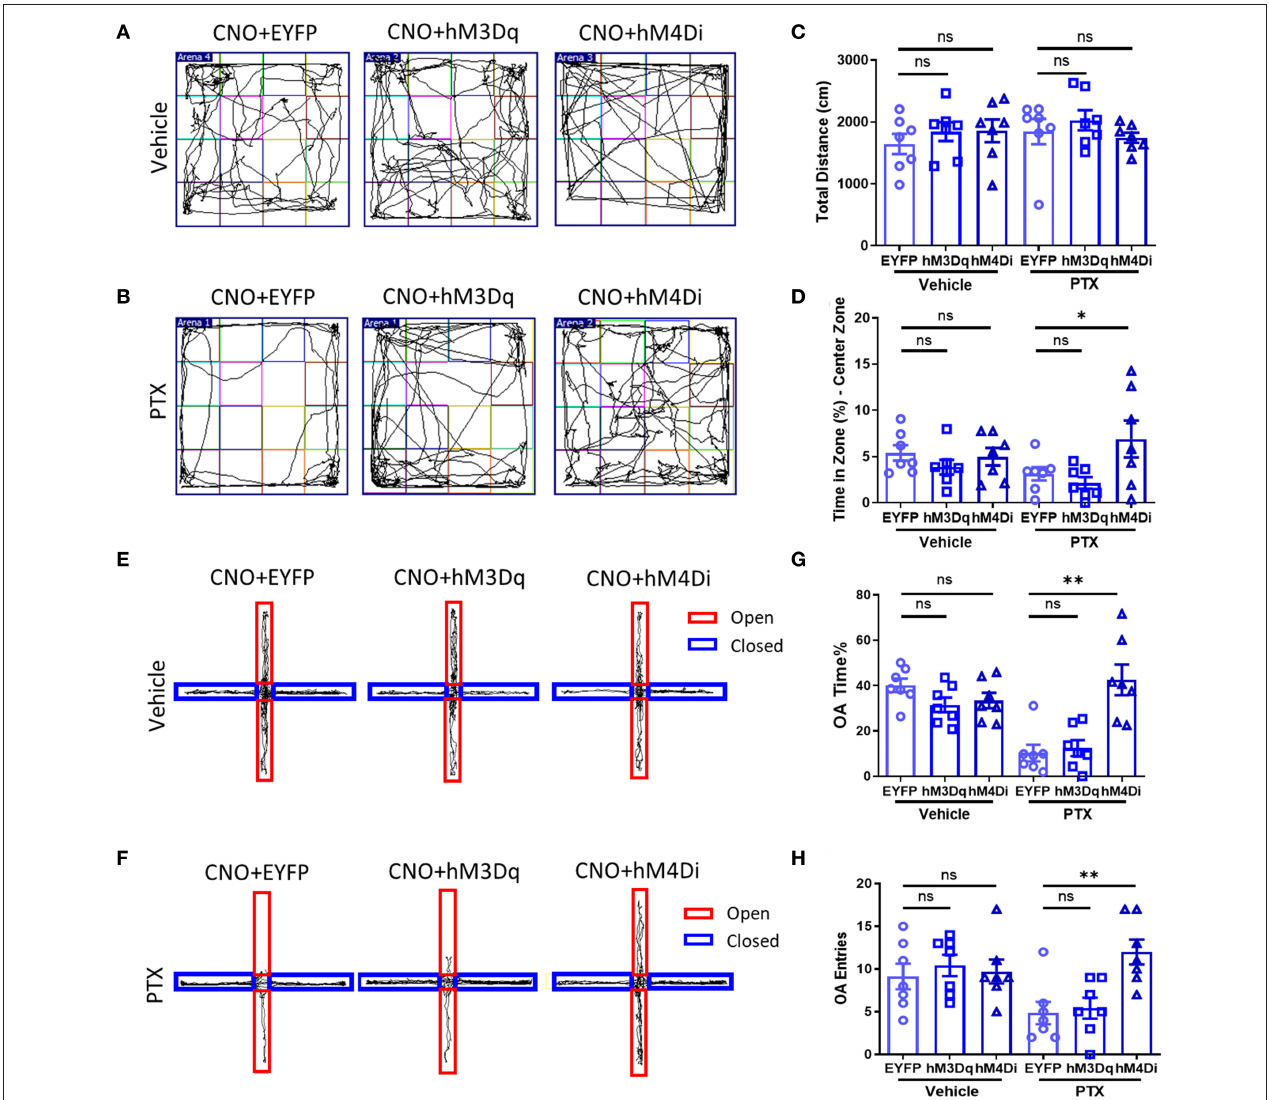
FIGURE 5 | Chemogenetic inhibition of CaMKII neurons in BLA relieves anxiety-like behaviors. (A,B) Open field experiment trajectory diagram in vehicle and PTX group after activation or inhibition of CaMKII neurons. (C) The total distance in different groups (EYFP, hM3Dq, hM4Di). (D) The percentage of central area activity time in different groups (EYFP, hM3Dq, hM4Di). (E,F) Elevated plus maze experiment trajectory diagram in vehicle and PTX group after activation or inhibition of CaMKII neurons. (G) The percentage of the open arm entry time in different groups (EYFP, hM3Dq, hM4Di). (H) The Number of entries open arms in different groups (EYFP, hM3Dq, hM4Di). n = 7, ns, no significant, * P < 0.05, ** P <